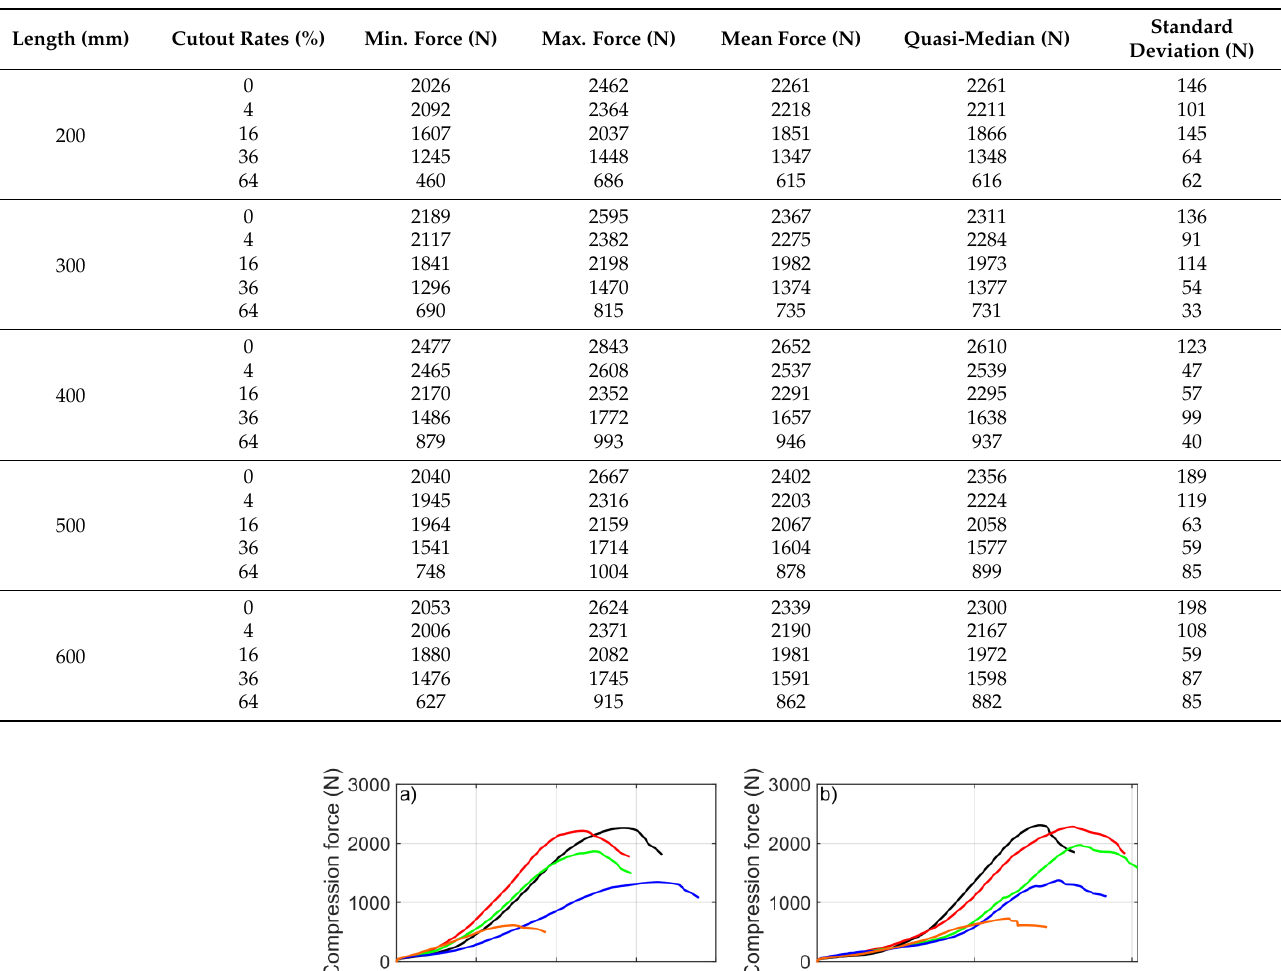
Table 4. BCT results for different box dimensions.